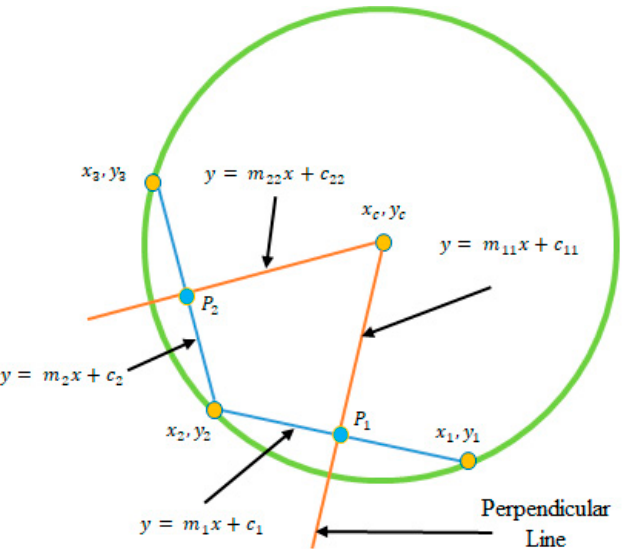
Figure 8. Calculation of the center of the circle.